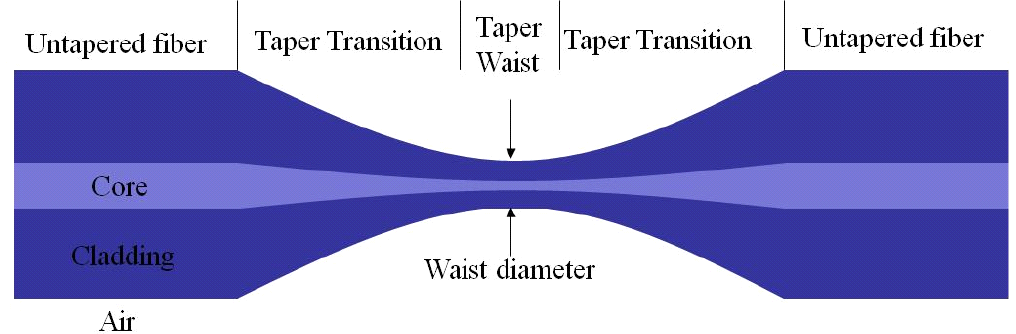
Figure 2. Schematic of a tapered fiber. The tapered fiber consists of three contiguous parts: one taper waist segment with small and uniform diameter, and two conical transition regions with gradually changed diameter. The ends of conical transition regions are untapered